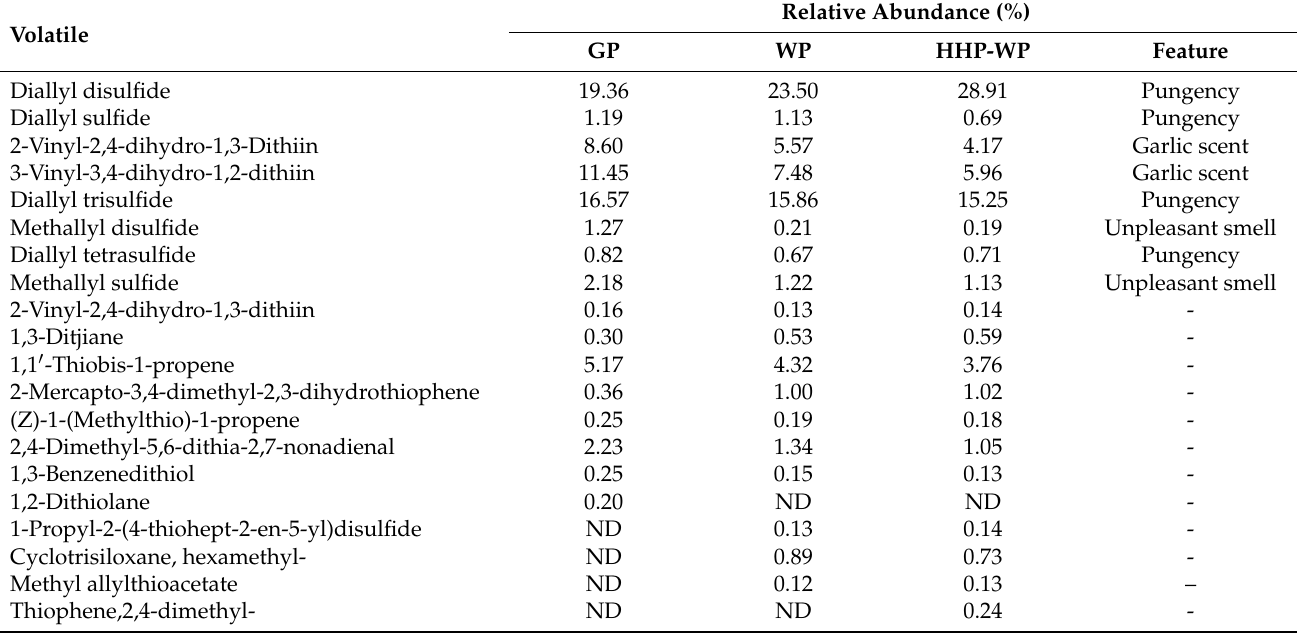
Table 1. Changes in flavor compounds after WPI and HHP